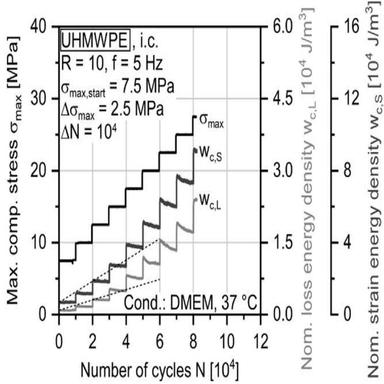
Result of a load increase test (LIT) on UHMWPE in vitro with superimposed DMEM at 37 �C.